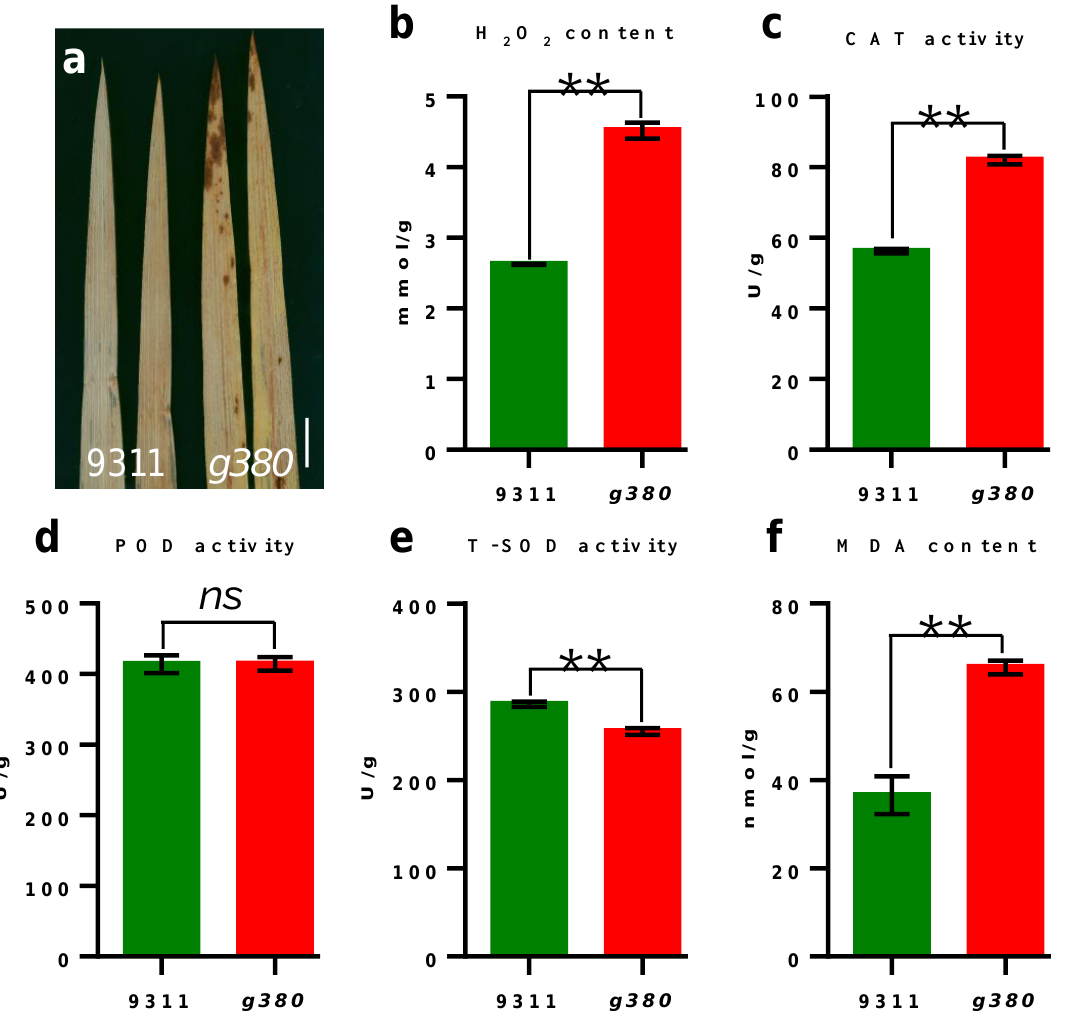
Figure 3. ROS accumulation in g380 after the lesion formation. ( a ) DAB staining of 9311 and g380 leaves. ( b – f ) The ROS related physiological–biochemical indexes of 9311 and g380 leaves. Bar = 1 cm in ( a ). Values are mean ± SD ( n = 6). ** indicates significant differences at p < 0.01 level by Welch’s t - test.